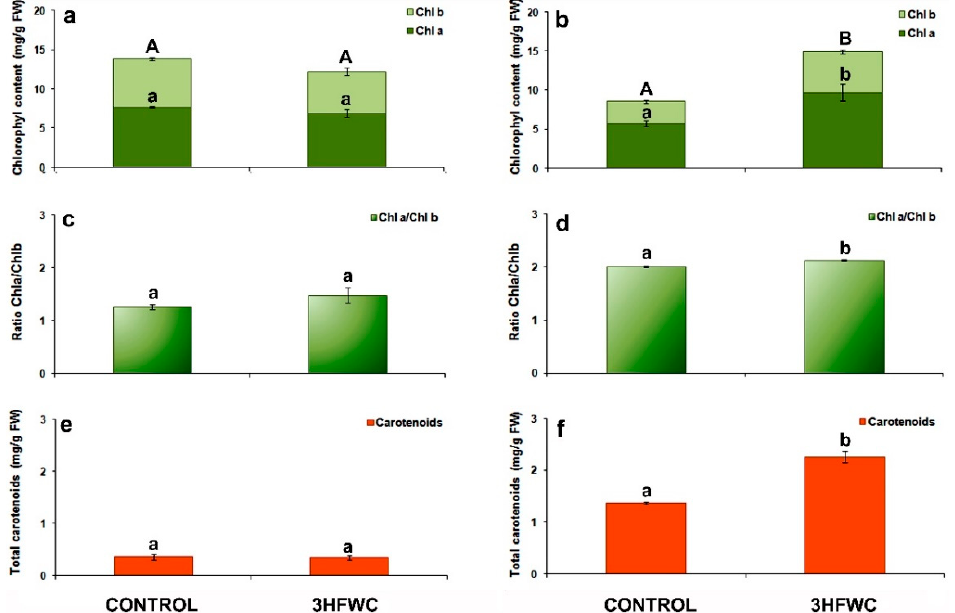
Figure 3. The effect of 3HFWC substance on pigment content in cherry tomato leaves. ( a , b ) Chloro- phyll a ( Chl a ) and chlorophyll b ( Chl b ) content in cherry tomato leaves after 4 ( a ) and 12 weeks ( b ) of growth; ( c , d ) Chl a / Chl b ratio in cherry tomato leaves after 4 ( c ) and 12 weeks ( d ) of growth; ( e , f ) Total carotenoid content in cherry tomato leaves after 4 ( e ) and 12 weeks ( f ) of growth. The presented data are mean value ± standard error. Different letters indicate statistically significant differences according to LSD test ( p ≤ 0.05).